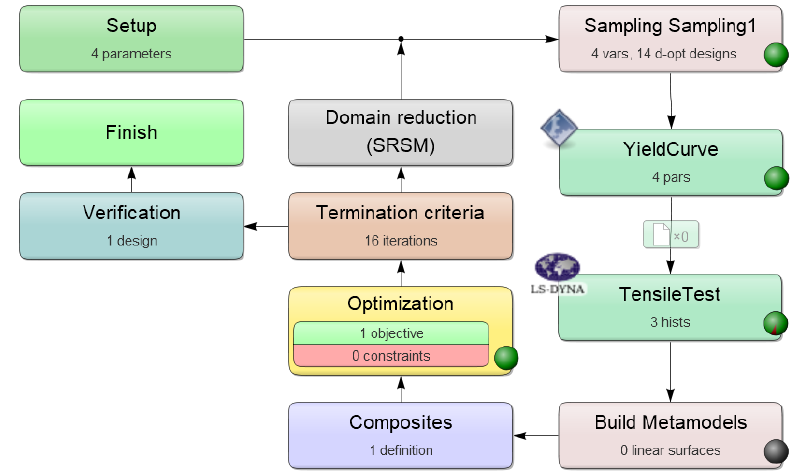
Figure 1. Parameter identification process to obtain the four material parameters for the custom yield function of MAT024 with